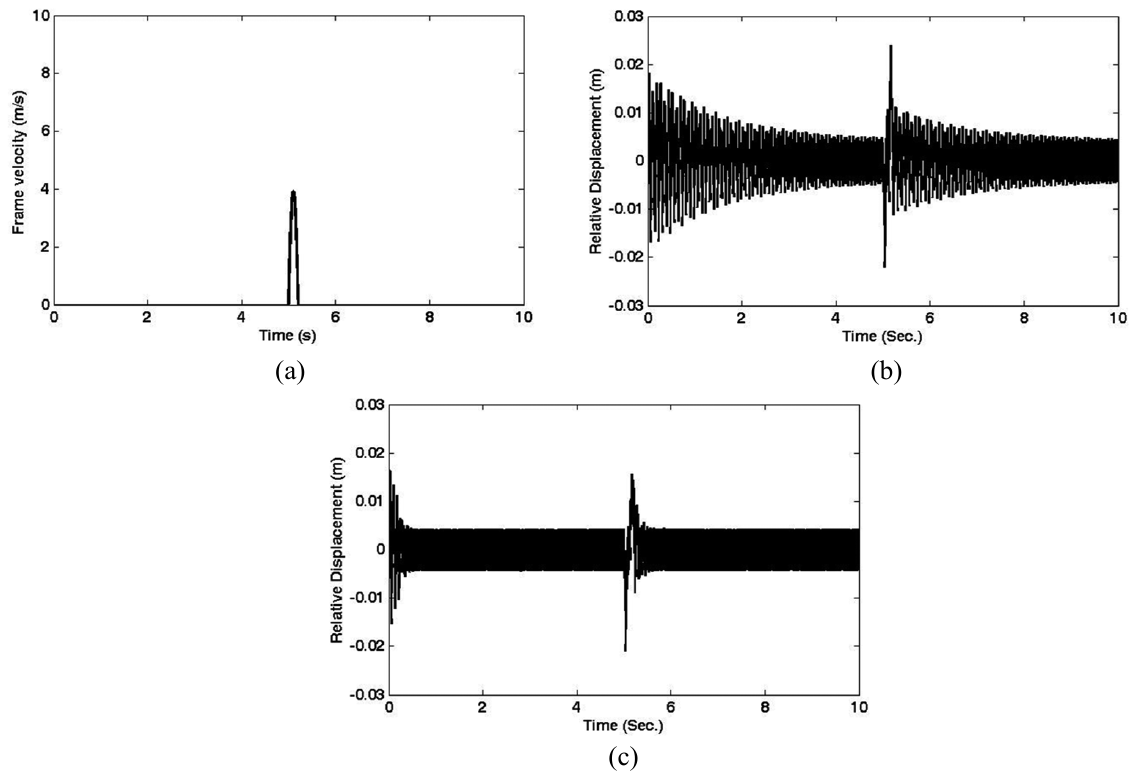
Fig. 15. (a) Frame velocity input, (b) Relative displacement between engine and frame in the passive mode, (c) Relative displacement between engine and the frame in the semi-active mode. measured by a tachometer and the later is measured by two accelerometers mounted on the engine and the